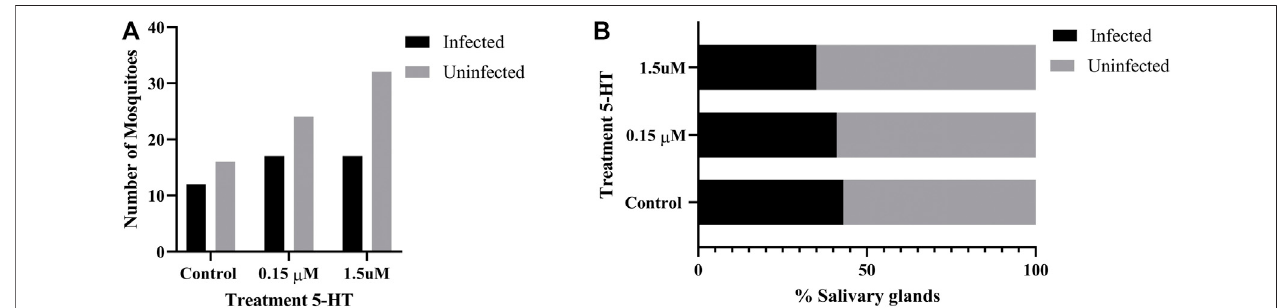
FIGURE 11 | P. falciparum NF54 sporozoite infection in A. stephensi following a bloodmeal provisioned with 5-HT or water (control). (A) Numbers of A. stephensi withsalivaryglandsinfectedwith P.falciparum NF54sporozoitesand (B) datafrom (A) shownaspercentagesofsporozoite-infectedanduninfectedmosquitoesineach group. N = 6; Fisher ’ s exact test ( α = 0.05), no signi fi